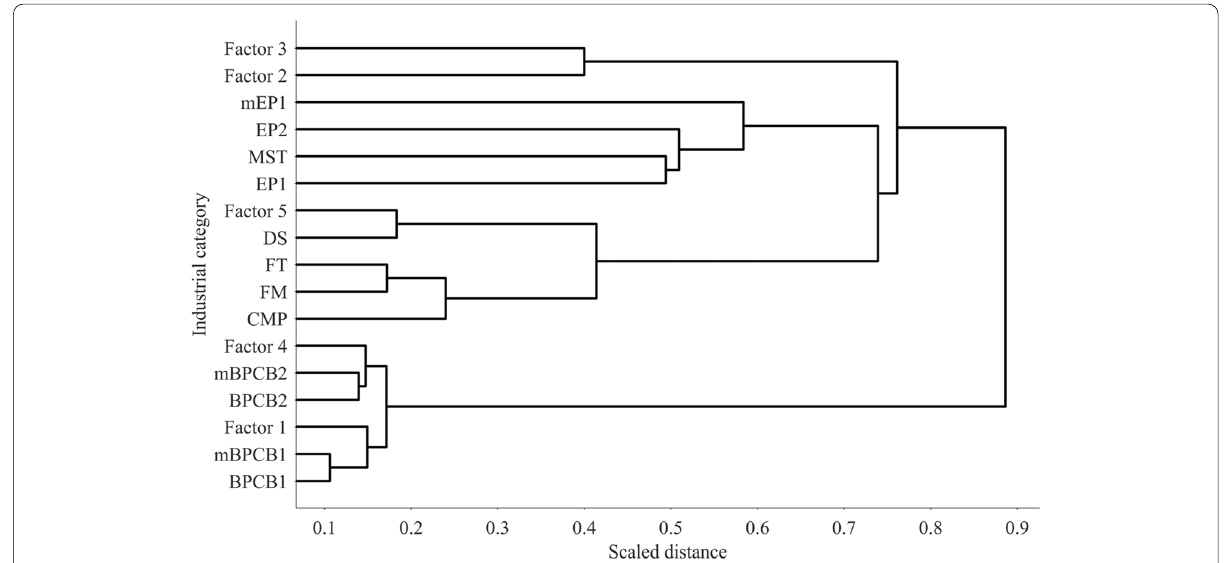
Fig. 6 Cluster dendrogram of hierarchical